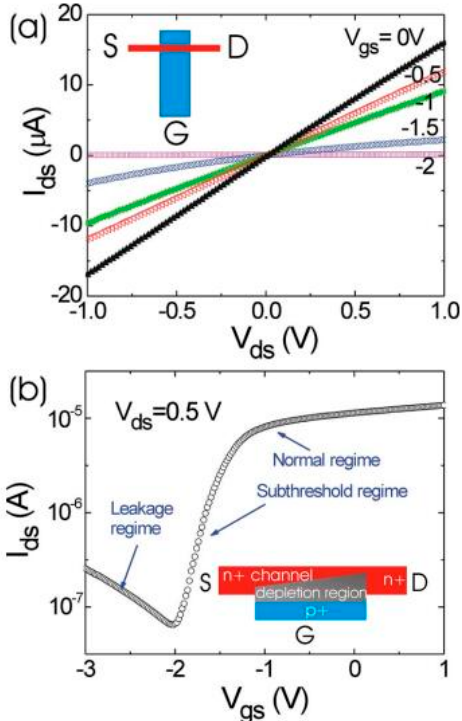
Figure 15. ( a ) Gate voltage-dependent I ds - V ds characteristics of a crossbar junction field effect transistor. The inset shows the schematic diagram of the crossbar junction field effect transistor constructed with Si nanoribbon as a gate and CdSe nanowire as a source-drain channel. ( b ) I g - V gs curve measured at V ds = 0.5 V. A depletion layer with its thickness controlled by V gs is formed at the